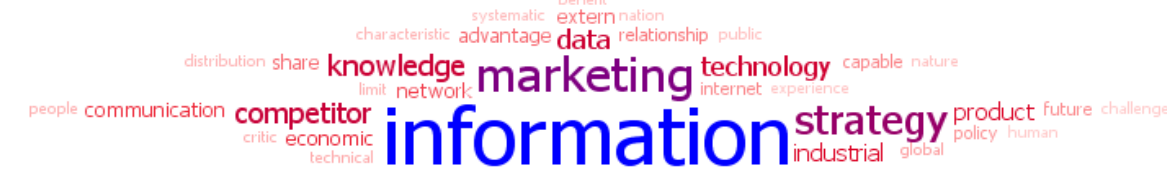
Figure 2. Word cloud of first